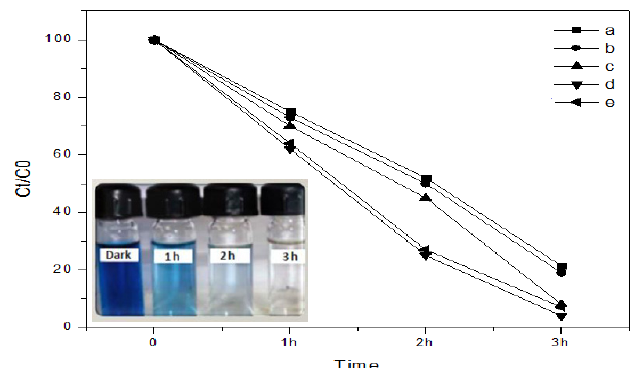
Fig.6. The photocatalytic degradation curves of MB using (a) n-CeO